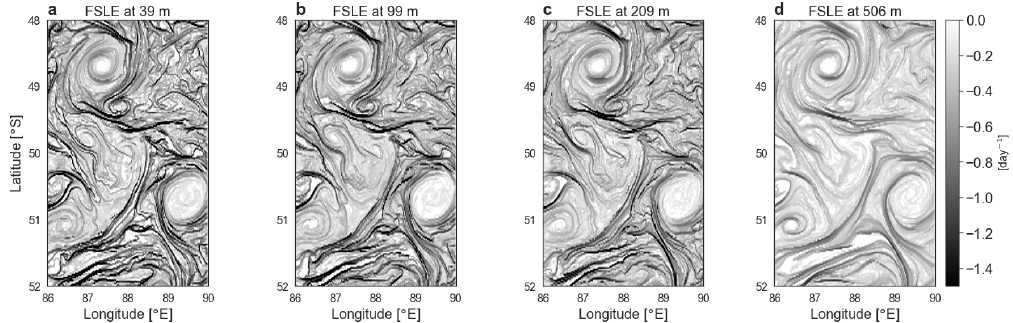
Figure 6. Finite-size Lyapunov exponent (FSLE) computed from the full model velocity field at ( a ) 39 m, ( b ) 99m, ( c ) 209 m, ( d ) 506 m. Randomly selected snapshot taken on 27 October 2011 00:00:00